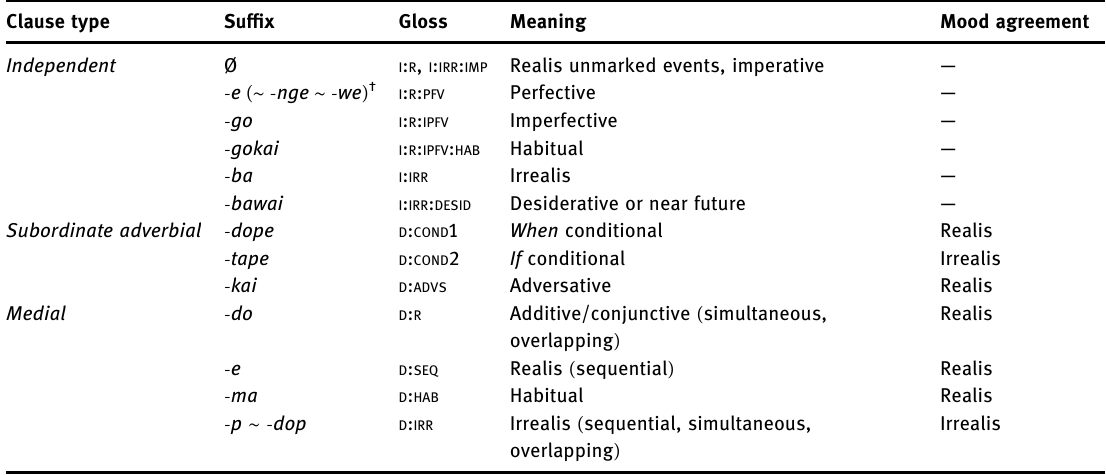
Table 1: Matukar Panau TAM verbal su ffi xes Clause type